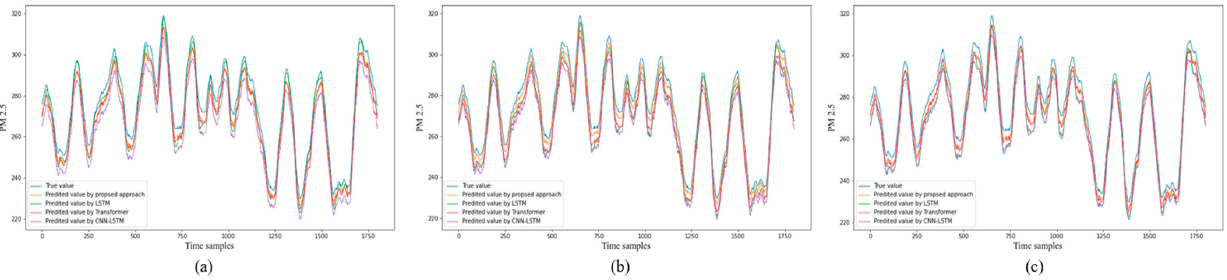
proach (Single-Dense Layer BiLSTM).